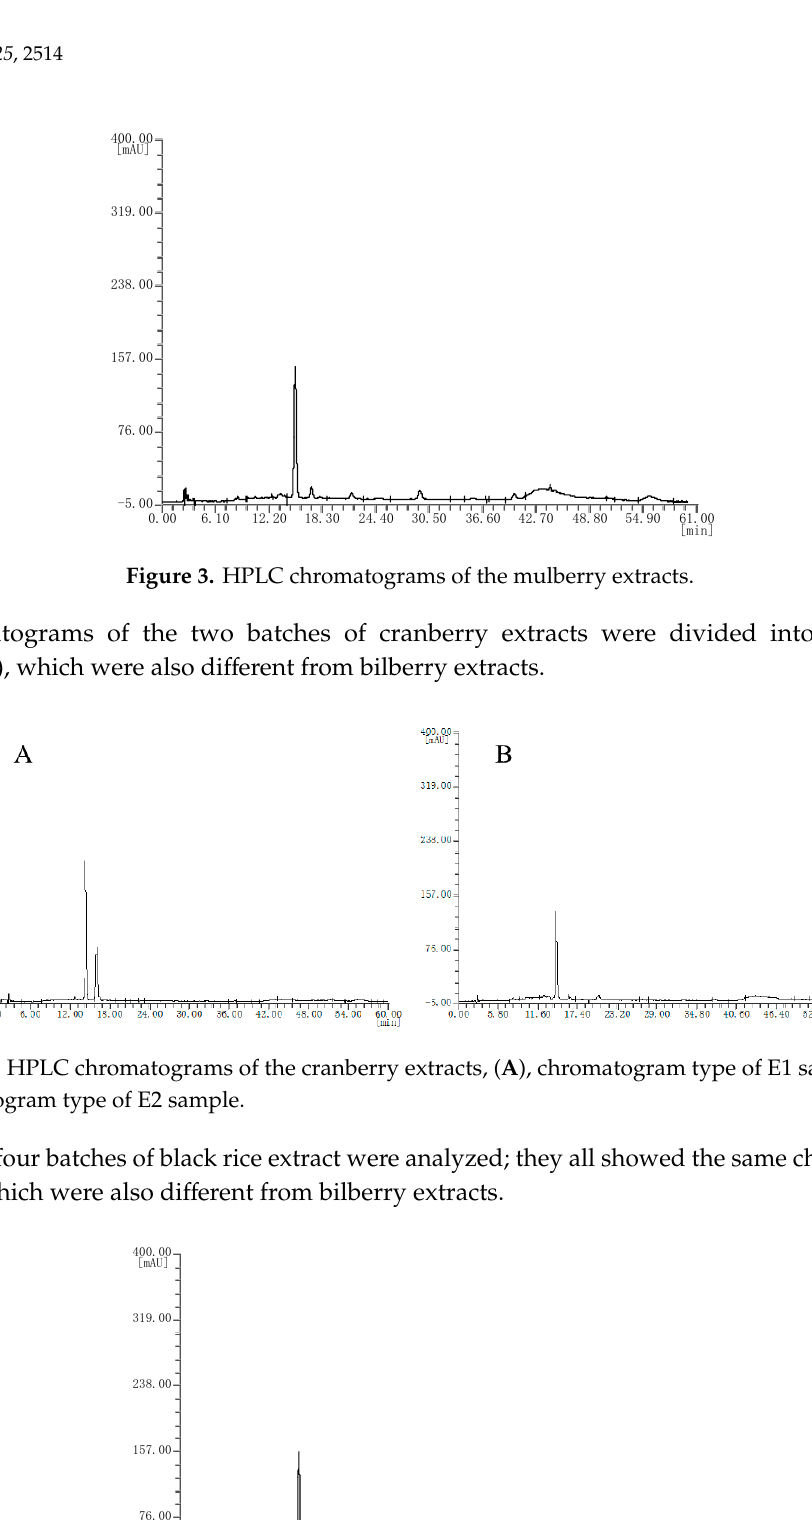
Figure 2. HPLC chromatograms of the blueberry extracts, ( A ), chromatogram type of B2 and B3